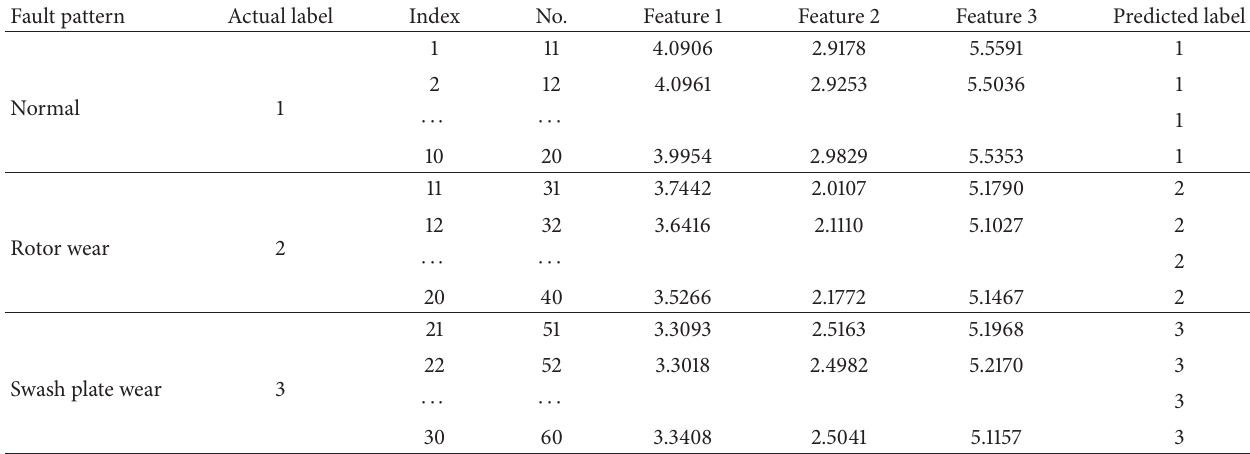
Table 3: Classification results of the testing